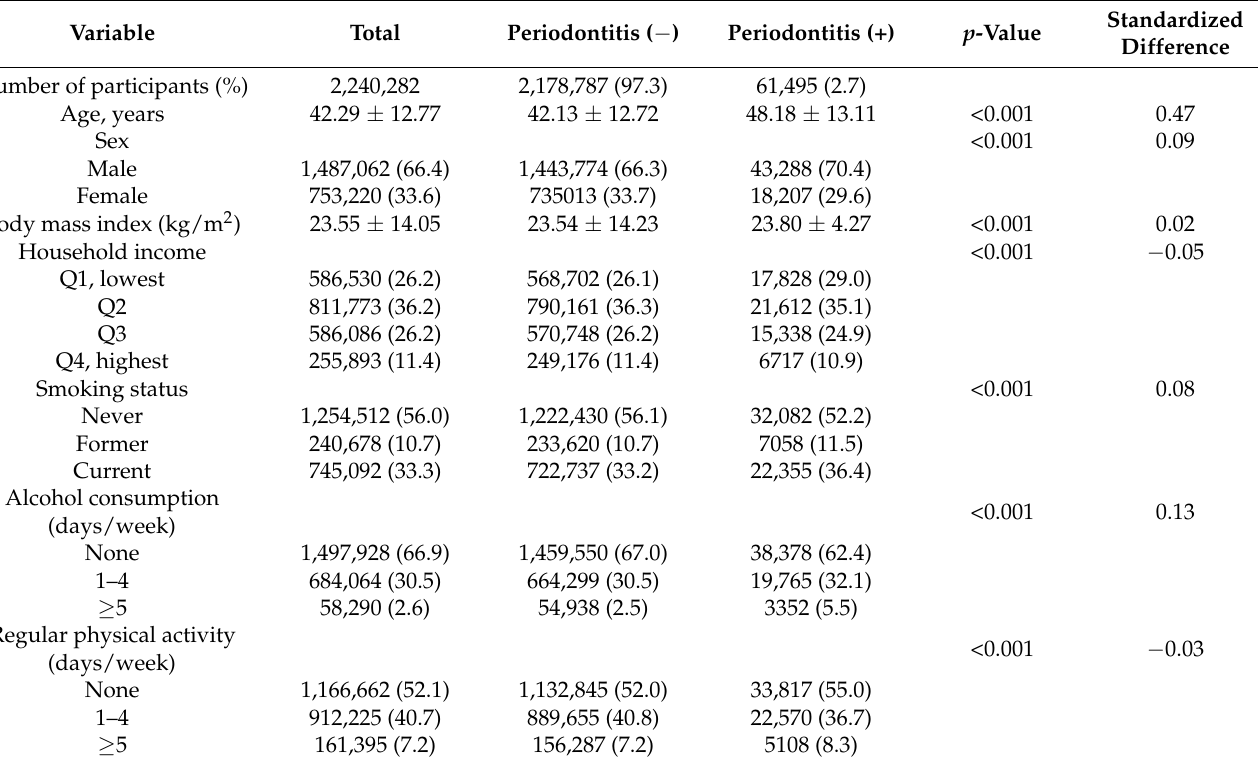
Table 1. Baseline characteristics of the participants according to the presence of